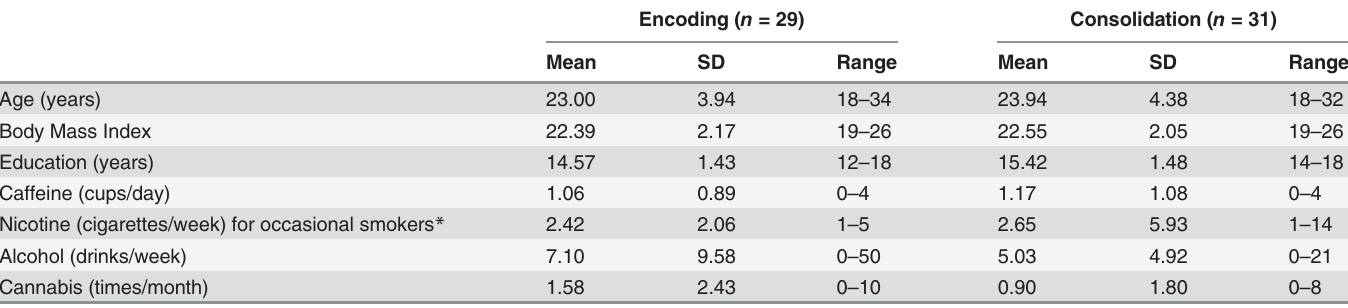
Table 2. Participants ’ demographics and recent drug use by